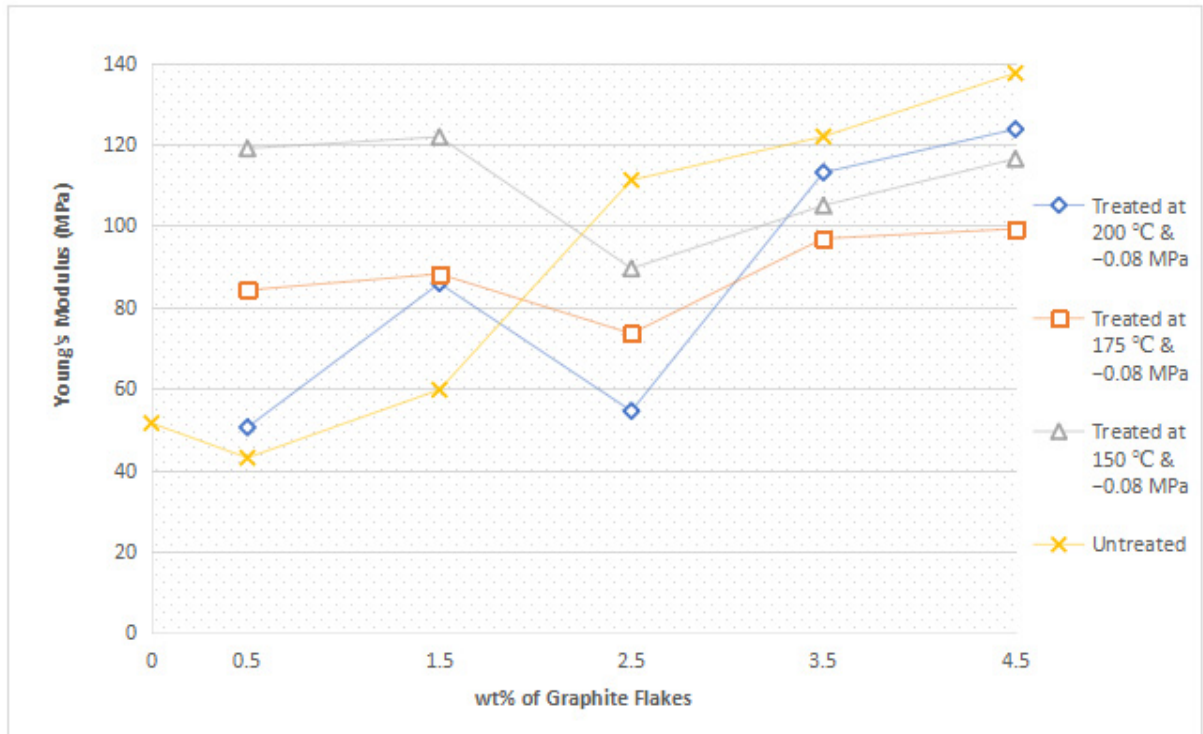
Figure 2 . Average Tensile Strength of All the Nylon 610/Graphite Flake Nanocomposites .